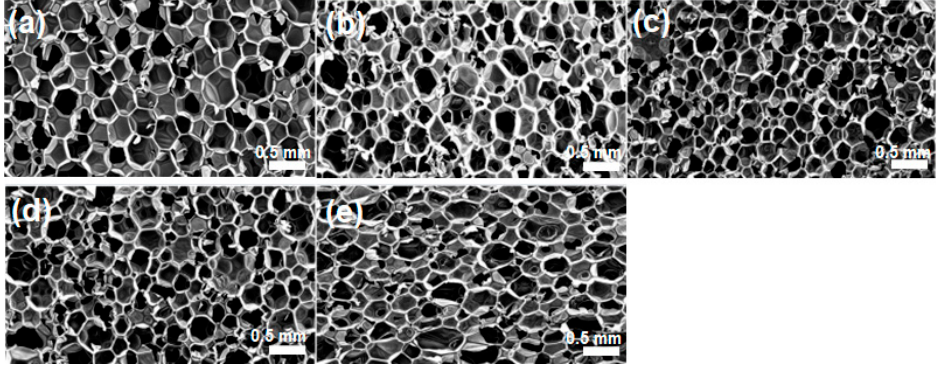
Figure 5. SEM images of neat PU foam without additive ( a ) and PU composite foams with silica filler by sol-gel reaction at different composition of without surface modification at different aerogel compositions of ( b ) 0.5 wt%, ( c ) 1 wt%, ( d ) 1.5 wt%, and ( e ) 3 wt%. compositions of ( b ) 0.5 wt%, ( c ) 1 wt%, ( d ) 1.5 wt%, and ( e ) 3